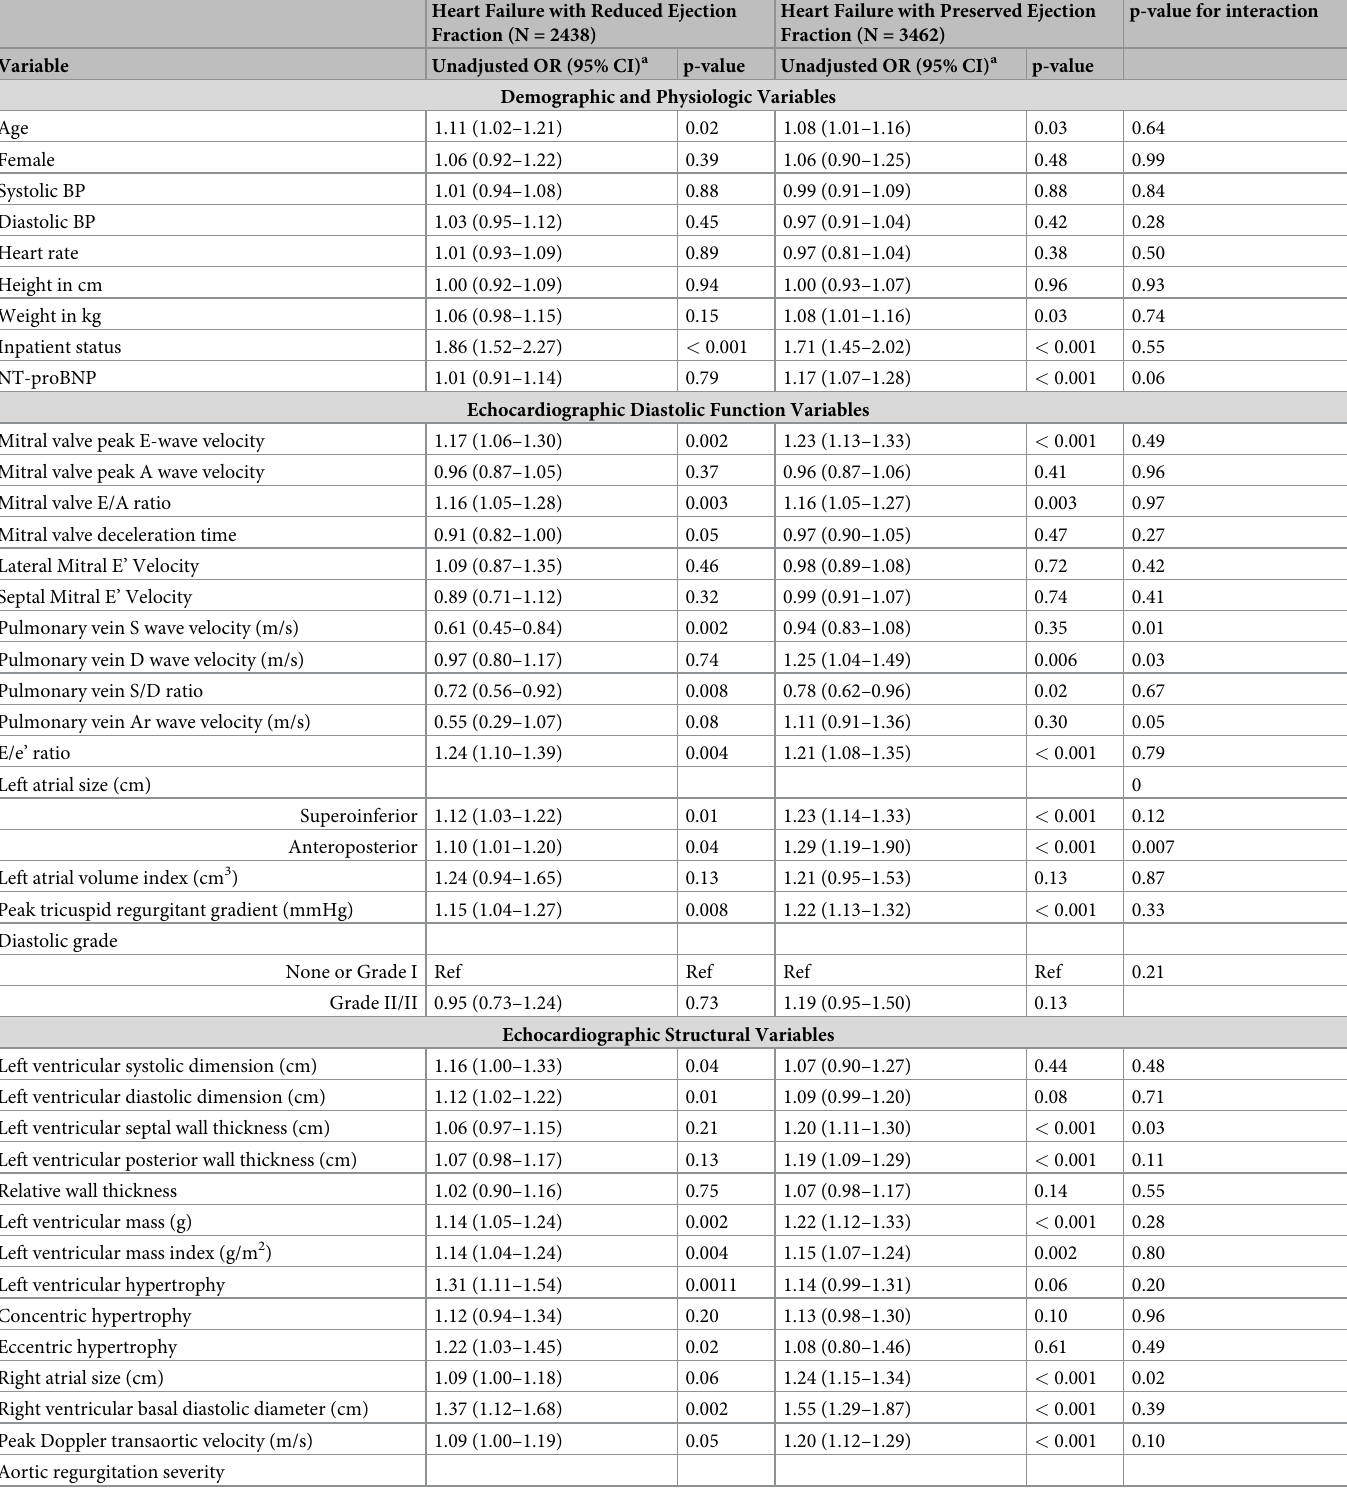
Table 2. Standardized univariate effect sizes for prediction of heart failure readmission by presence or absence of reduced left ventricular systolic